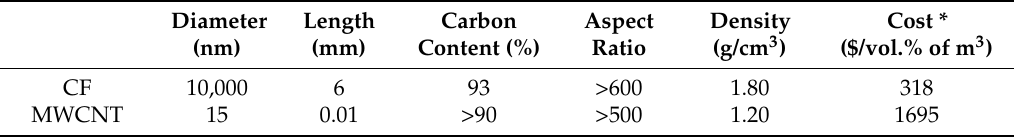
Table 2. Physical properties and cost of CF and